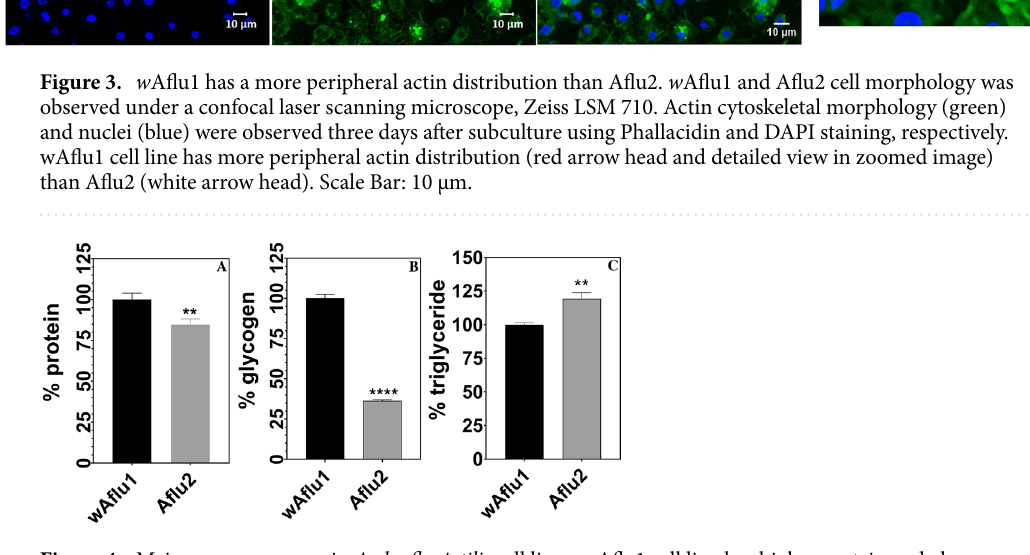
Figure 4. Major energy sources in Aedes fluviatilis cell lines. w Aflu1 cell line has higher protein and glycogen contents in comparison to Aflu2 cell line ( A , B ), while Aflu2 cells have more lipids (Triglycerides) than w Aflu1 ( C ). The experiments were performed with three independent biological samples in three experimental replicates each, ** p < 0.01; **** p < 0.0001, using student’s